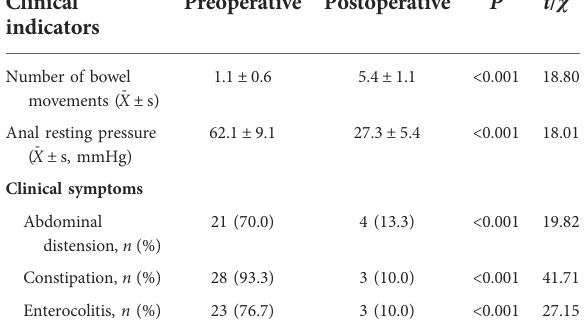
TABLE 2 Outcomes after the fi rst botulinum toxin injection ( N =30).